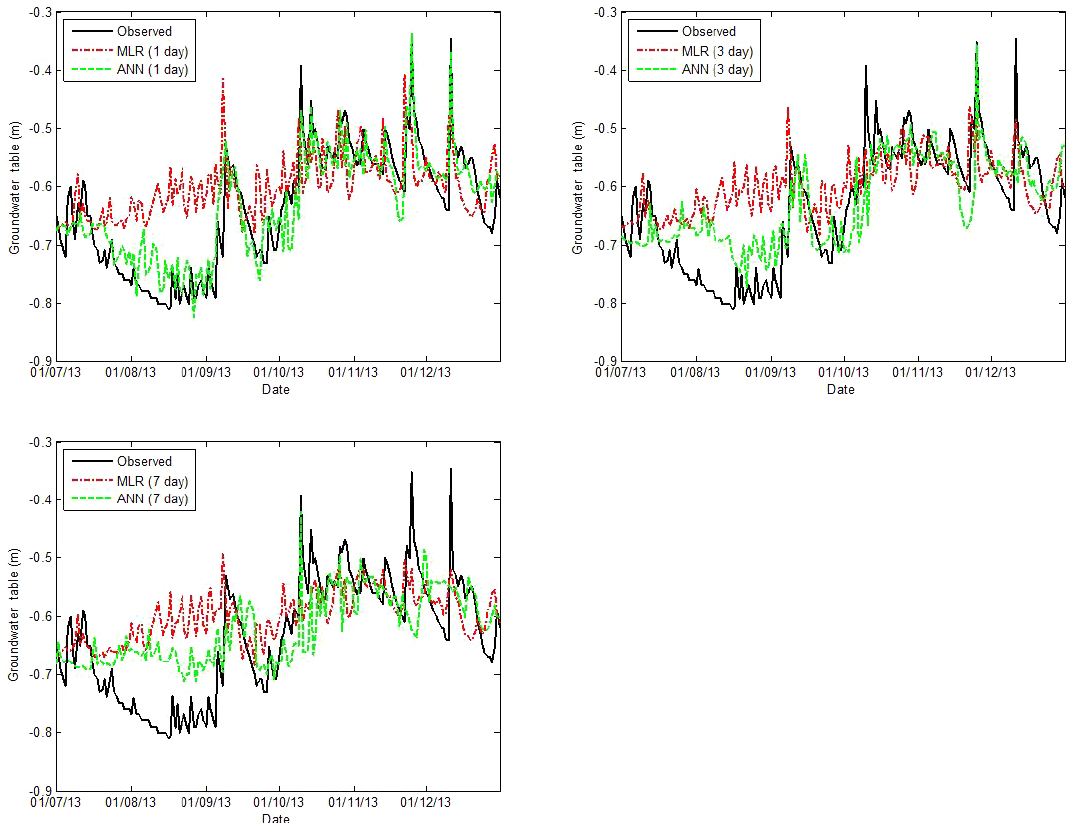
Figure 2. Observed vs. MLR- and ANN-forecasted groundwater tables